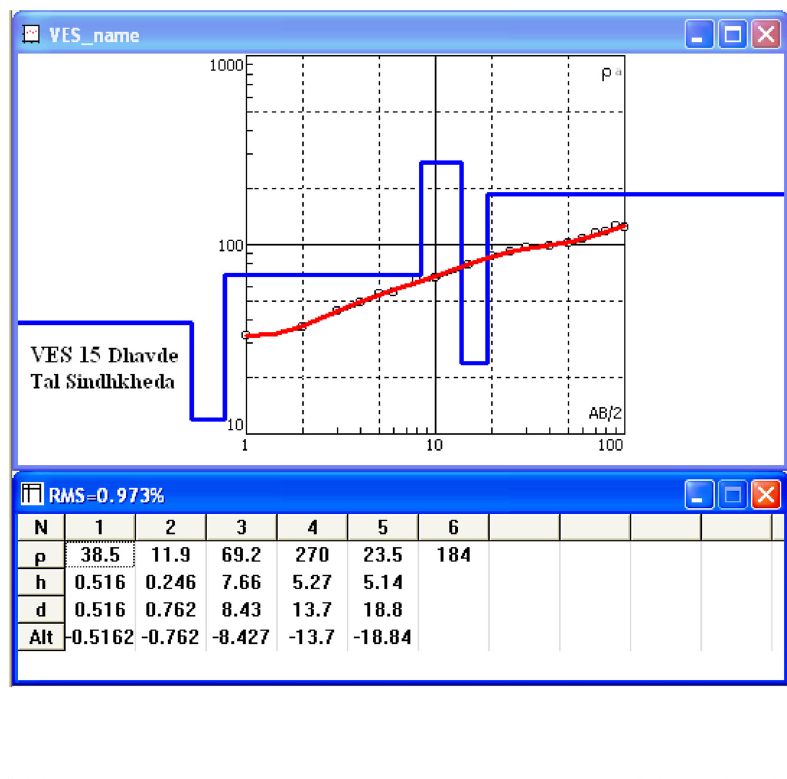
Fig. 10 Representative sounding curves are interpreted as per Orellana and Mooney by Schlumberger methods from Shirpur